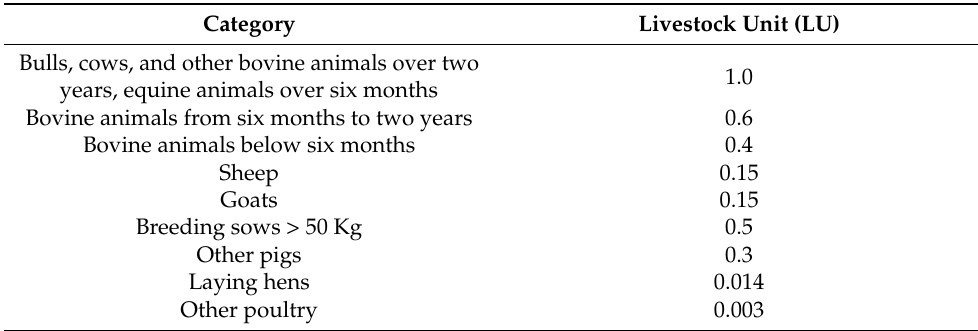
Table 3. Table of conversion of animals to livestock units from EU L 368, article 27(13) adopted in the present work to estimate the animal farming-induced pressure on